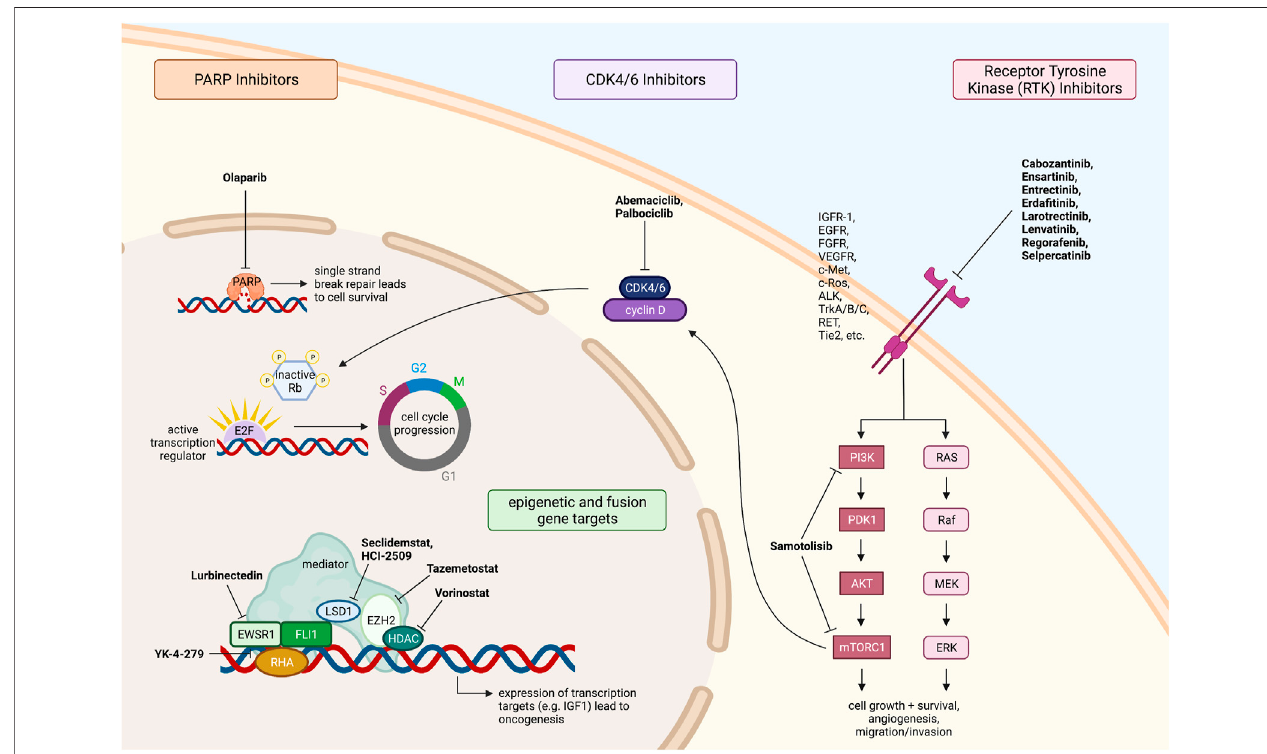
FIGURE1| Fusiondrivenpediatricsolidtumorswithclinicallyactionabletargets.Ewingsarcomatherapeutictargetsanddrugsunderinvestigation.All fi gureswere created with BioRender.com.